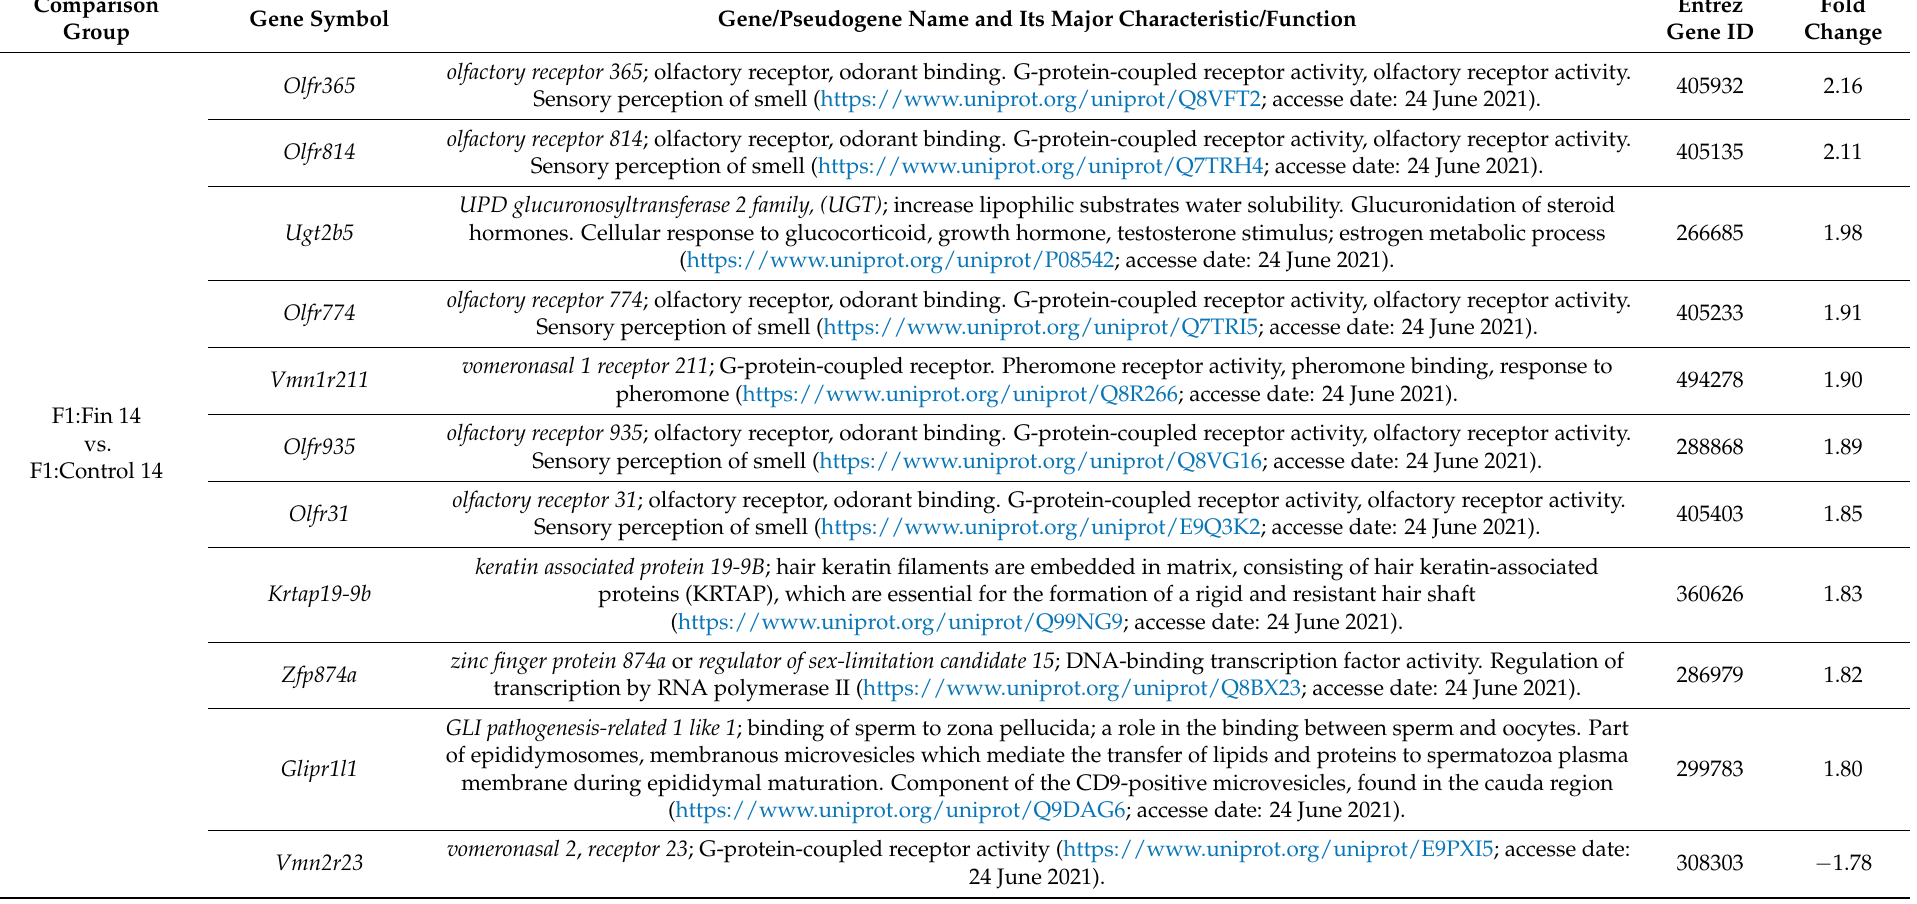
Table 1. Top 10 genes with the highest and lowest values of the fold expression change within the four individual comparison groups: F1:Control 14 vs. F1:Fin 14, F1:Control 90 vs. F1:Fin 90, F1:Control 14 vs. F1:Control 90, F1:Fin 14 vs. F1:Fin 90. Characteristic of gene/pseudogene function mainly from uniprot.org (accesse date: 24 June 2021) or ncbi.nlm.nih.gov